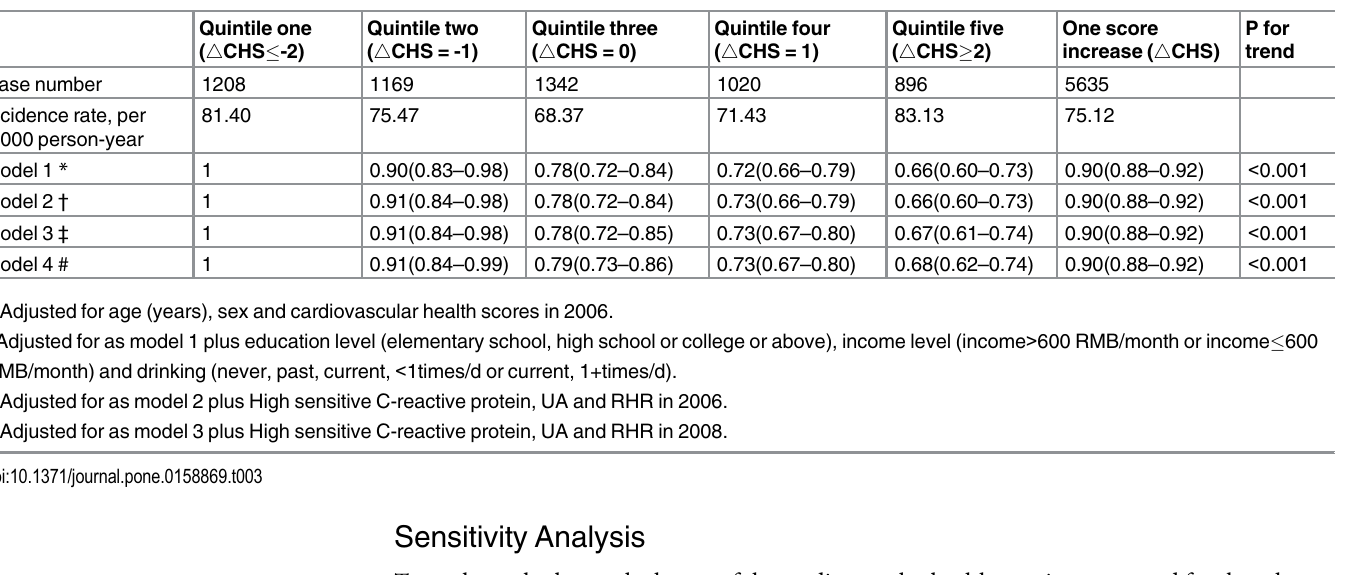
Table 3. Hazard ratios (HRs) and 95% confident intervals (95% CIs) of hypertension according to change of cardiovascular health scores ( 4 CHS) from 2006 to